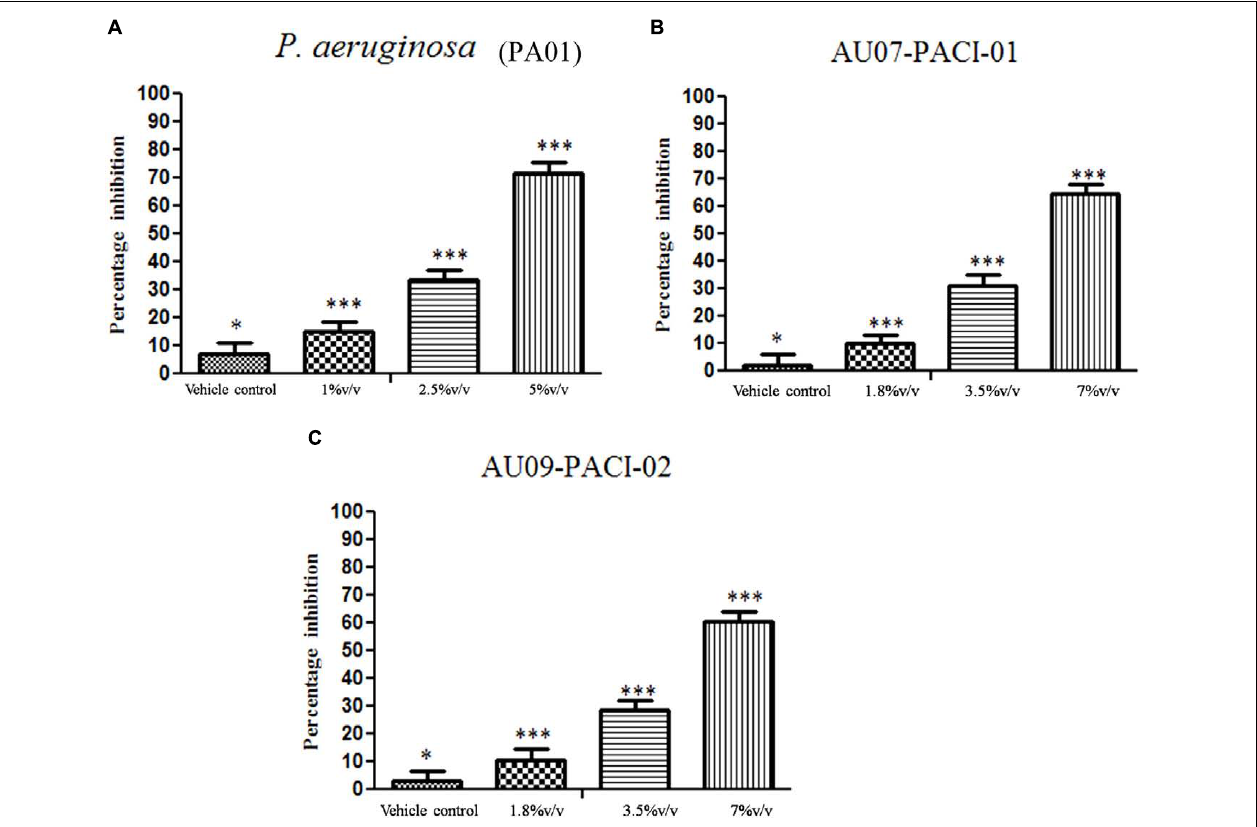
FIGURE 9 | Inhibition of alginate production (A) P. aeruginosa biofilm in the presence of EO (1–5% v/v), (B) AU07-PACI-01 biofilm in the presence of EO (1.8–7% v/v), (C) AU09-PACI-02 biofilm in the presence of EO (1.8–7% v/v). Mean values of triplicate independent experiments ± SD are shown. One-way ANOVA test demonstrates significant difference between the control and the test. Single asterisk indicates significant at P ≤ 0.025 and triple asterisk indicates significant at P ≤ 0.005.